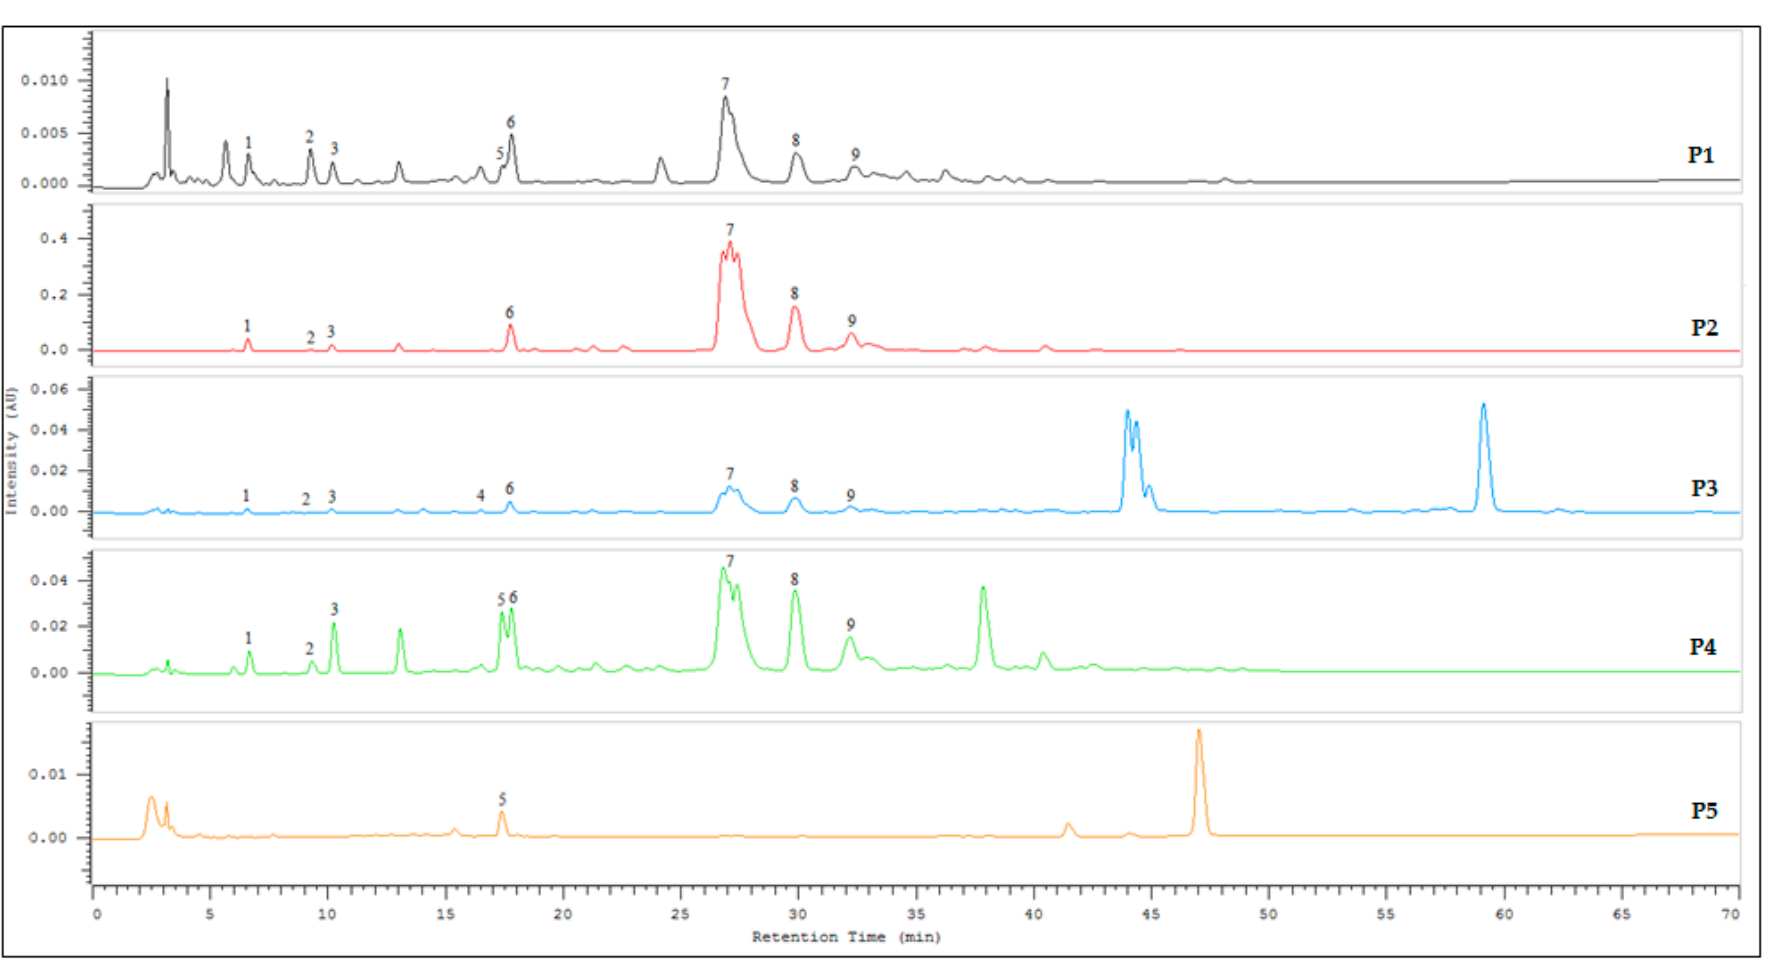
Figure 1. Chromatograms for propolis samples (P1, P2, P3, P4, and P5) with identified marker compound. 1. Caffeic acid, 2. p -coumaric acid, 3. ferulic acid, 4. quercetin, 5. cinnamic acid, 6. naringenin, 7. pinocembrine, 8. chrysin, and 9. galangin.